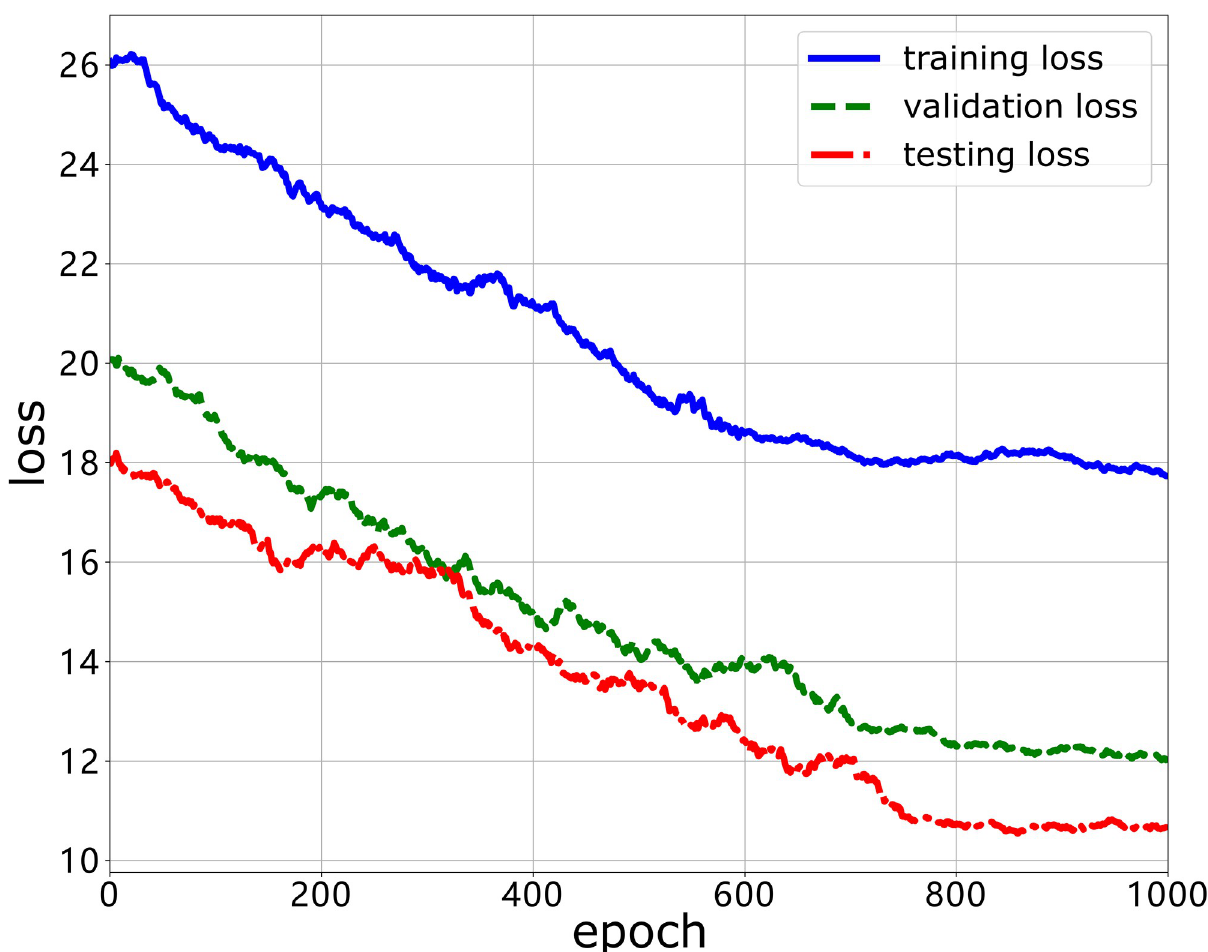
Fig 10. The model loss performance of our DNN model over the HAJP